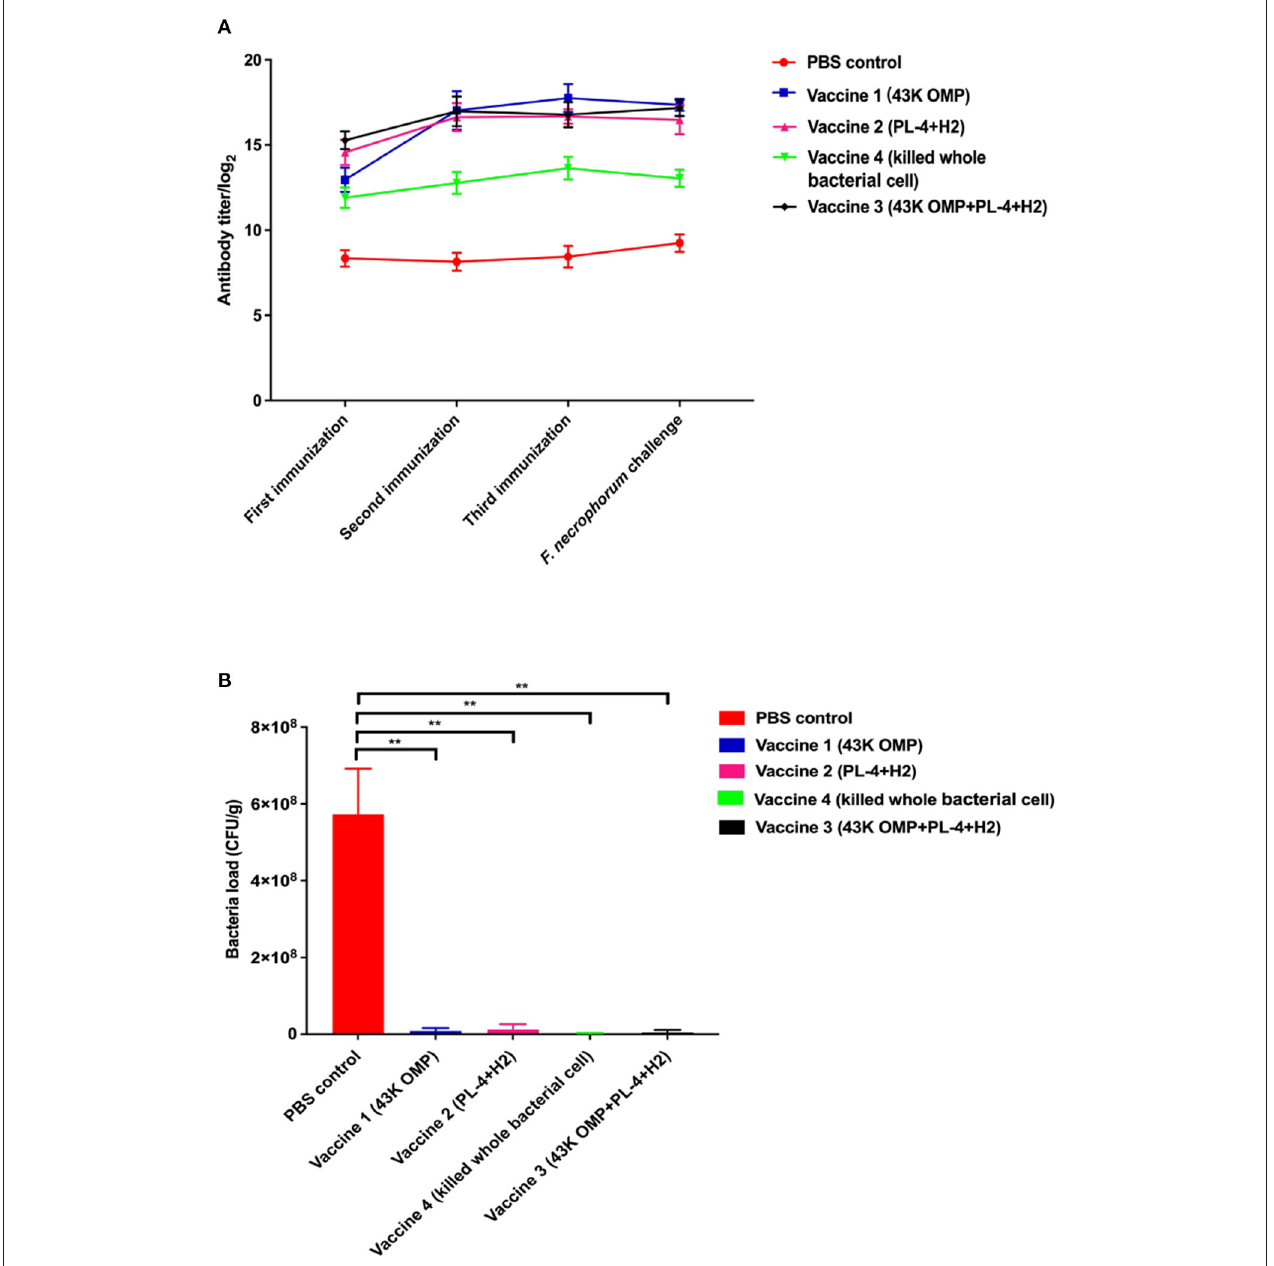
FIGURE 2 | (A) Antibody levels in mouse serum. (B) Number of bacteria in mouse liver. Data are represented as mean ± S.E.M. of three replicates. *A result significantly different (* P ≤ 0.05 and ** P ≤ 0.01) from their respective control.